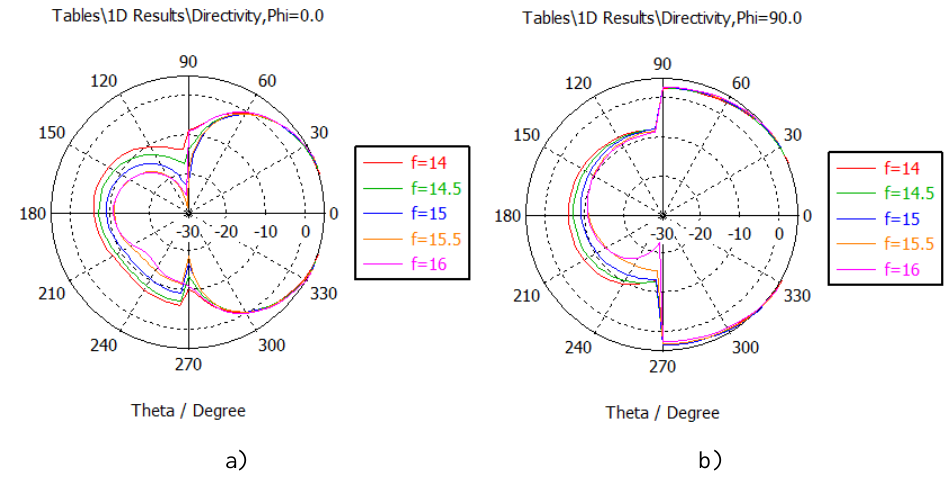
Fig. 4. Simulation results – emitter radiation